Question: Compose a caption that would accompany this figure in a paper.
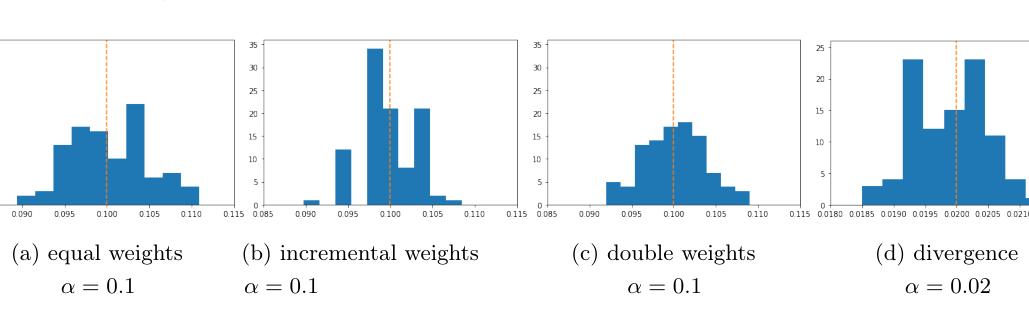
Answer: illustrates the risk distribution at a fixed α for different scenarios, where α is fixed at 0.10 for the first three scenarios and at 0.02 for the last scenario. It shows that for all the scenarios, the algorithm controls the risk well within narrow ranges around the specified α values, which are shown by the orange dotted lines in the graphs.